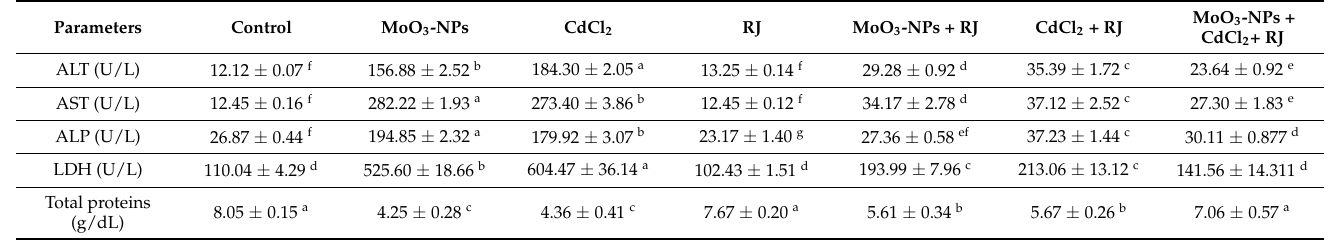
Figure 9. Showing the Zeta potential curve of the prepared MoO 3 -NPs ( − 16.2 mV). Table 1. Assessment of royal jelly (RJ) on serum enzyme activity of male rats treated with molybde- num nanoparticles (MoO 3 -NPs), cadmium chloride (CdCl 2 ), or their combinations for 30 consecu- tive